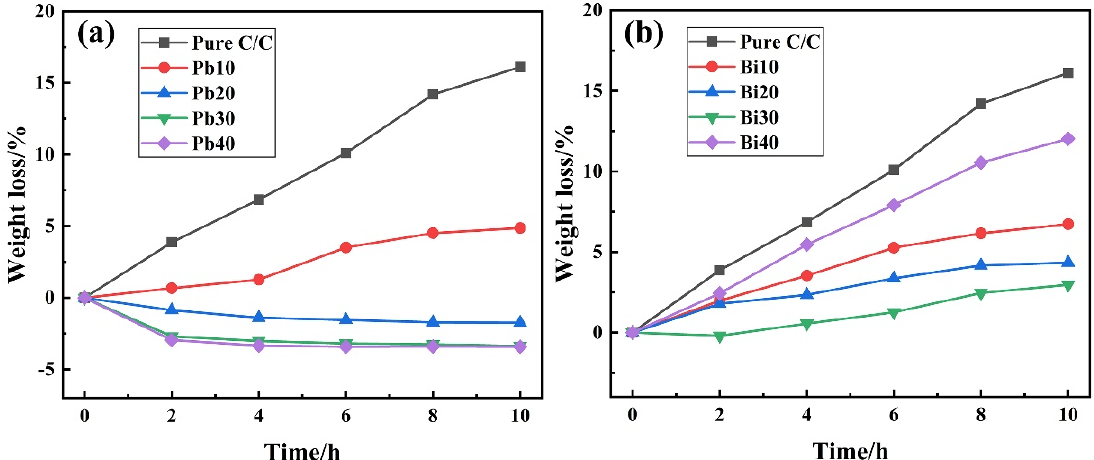
Figure 4. The isothermal oxidation curves of C/C with and without coatings at 500 °C in air: ( a ) PSN/lead–borosilicate glass–B 4 C coatings; and ( b ) PSN/bismuth–borosilicate glass–B 4 C coatings.